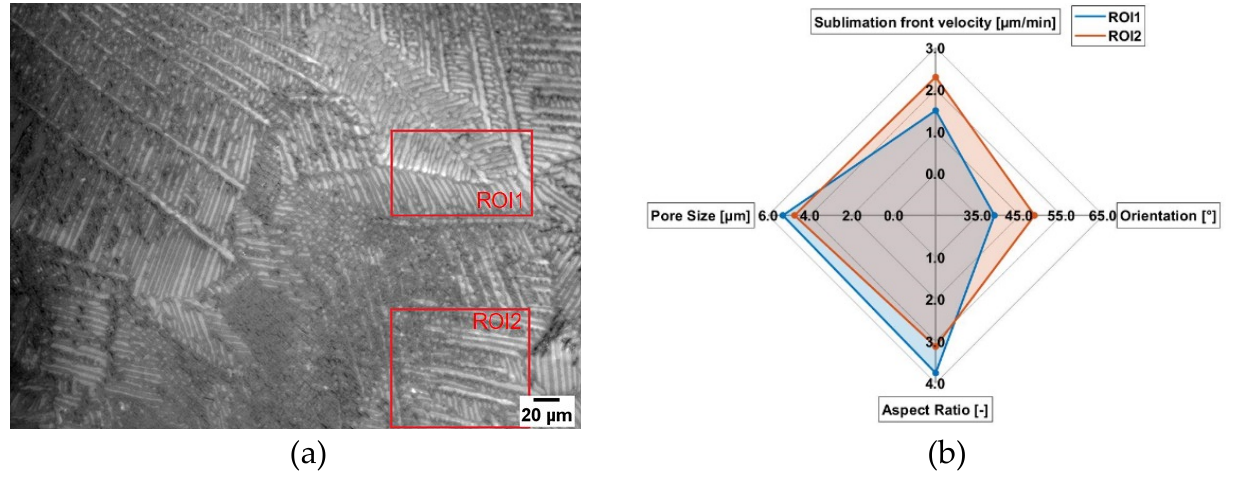
Figure 11. Influence of the microstructure on the local sublimation front velocity for sucrose (c = 0.15 w/w, 50 K/min cooling rate). ( a ) Lyomicroscope Image and ( b ) Results